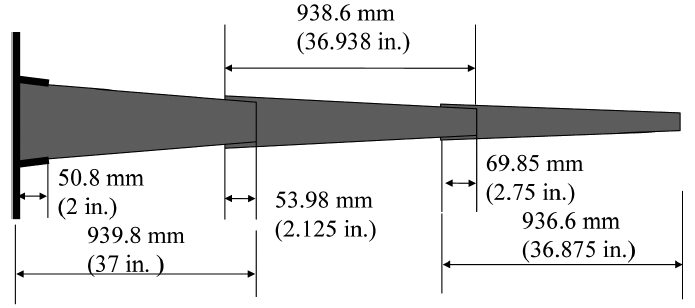
Fig. 5. Deformed con fi guration of a cantilever beam subjected to a transverse end load [32], where F = n π 4, 5, 6, 7].